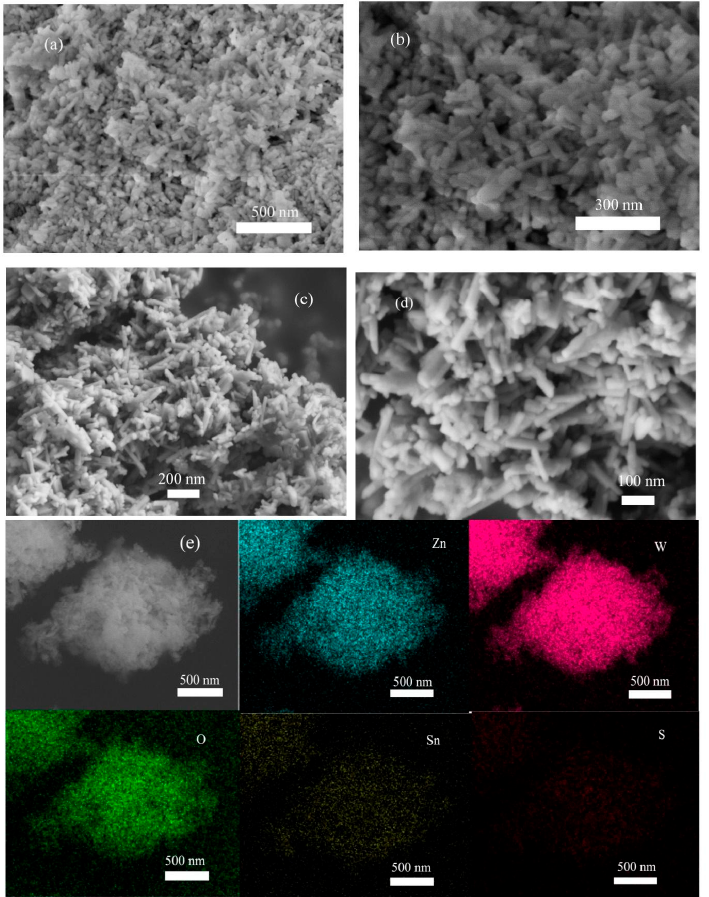
Figure 1. ( a , b ) Low magnification SEM image and high magnification SEM image of ZWO sample; ( c , d ) low magnification SEM image and high magnification SEM image of the SZWO-9 sample; ( e ) elemental mapping of the SZWO-9 sample.